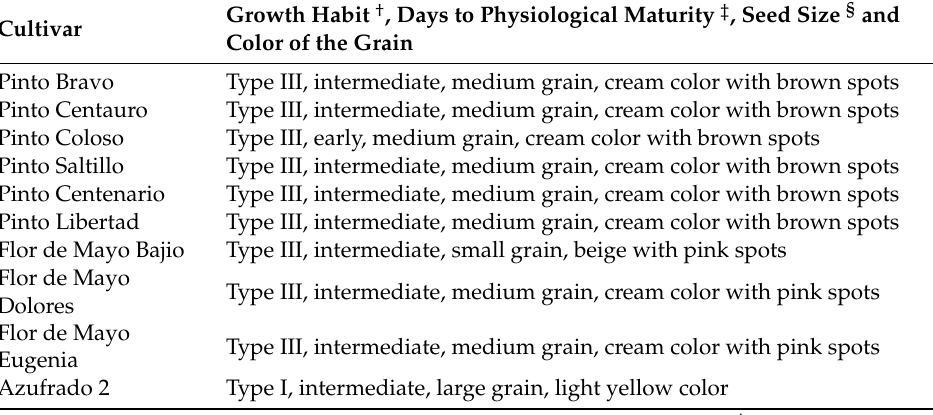
Table 1. Dry bean ( Phaseolus vulgaris L.) cultivars established at 90,000 plants ha − 1 , 145,000 plants ha − 1 , and 260,000 plants ha − 1 under rainfed conditions during the 2011 and 2013 growing seasons in Pabellon de Arteaga, Aguascalientes, Mexico. Growth Habit † , Days to Physiological Maturity ‡ , Seed Size § and Cultivar Color of the Grain Pinto Bravo Type III, intermediate, medium grain, cream color with brown spots Pinto Centauro Type III, intermediate, medium grain, cream color with brown spots Pinto Coloso Type III, early, medium grain, cream color with brown spots Pinto Saltillo Type III, intermediate, medium grain, cream color with brown spots Pinto Centenario Type III, intermediate, medium grain, cream color with brown spots Pinto Libertad Type III, intermediate, medium grain, cream color with brown spots Flor de Mayo Bajio Type III, intermediate, small grain, beige with pink spots Flor de Mayo Type III, intermediate, medium grain, cream color with pink spots Dolores Flor de Mayo Type III, intermediate, medium grain, cream color with pink spots Eugenia Azufrado 2 Type I, intermediate, large grain, light yellow color † Growth habit: Determinate shrub, Type I; Indeterminate semi-prostrate, Type III. ‡ Physiological